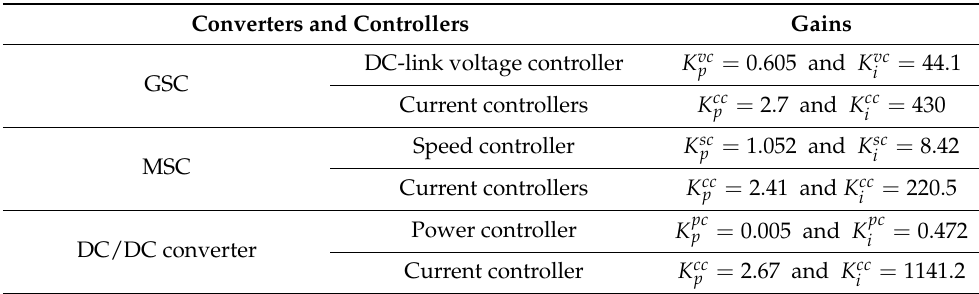
Table 5. Controller gains for the experimental system.